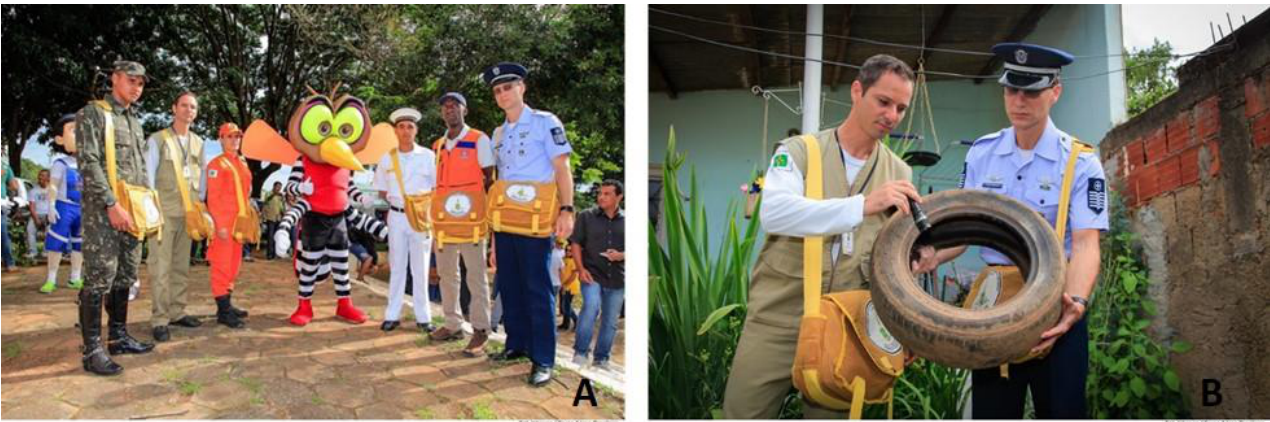
Figure 6. The Brazilian Air Force assisting in an exercise “all against Zika” in the local community, checking tyres containing water. ( A ) “Todos contra o Zika” by Força A é rea Brasileira—P á gina Oficial is licenced under CC BY-NC-SA 2.0. ( B ) “FAB participa de aç ã o de combate aos criadouros de mosquitos” (Brazilian Air Force (FAB) participates in actions against mosquito breeding sites) by Força A é rea Brasileira—P á gina Oficial is licenced under CC BY-NC-SA 2.0. Participants, including both favela residents and the academic community, felt that the information that was in circulation was misleading or ambiguous, in particular about the ZIKV and also the breeding habits of the Aedes aegypti mosquito, stating that for instance: “The vector of Zika . . . needs potable water to reproduce